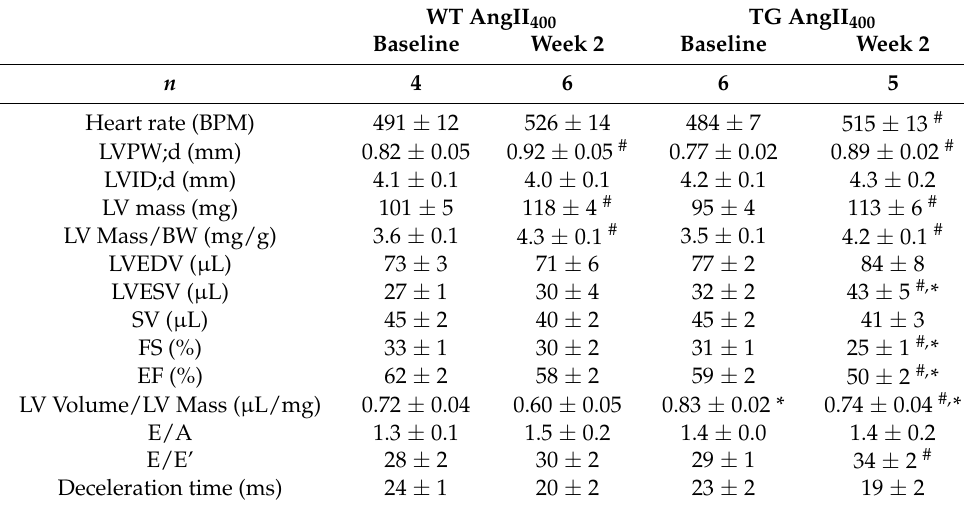
Table 3. In vivo left ventricular function assessed by transthoracic echocardiography in wild-type (WT) and csNOX2 transgenic (TG) mice treated with angiotensin II (AngII 400 ) for two weeks. Mea- surements were obtained and analysed from parasternal short-axis M-mode and apical four-chamber view. Data are presented as mean ±